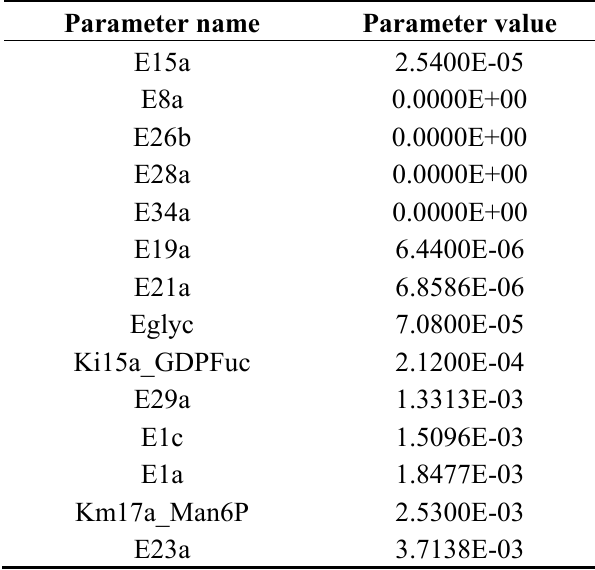
Table A3. NSD metabolic netowrk parameter